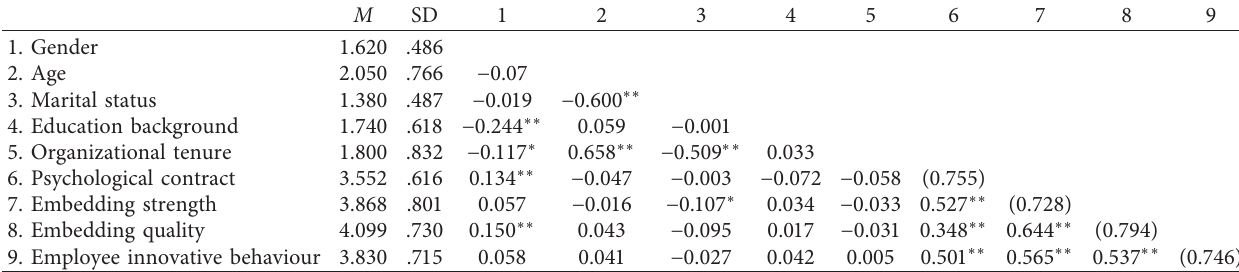
Table 3: Descriptive statistics and bivariate correlations.